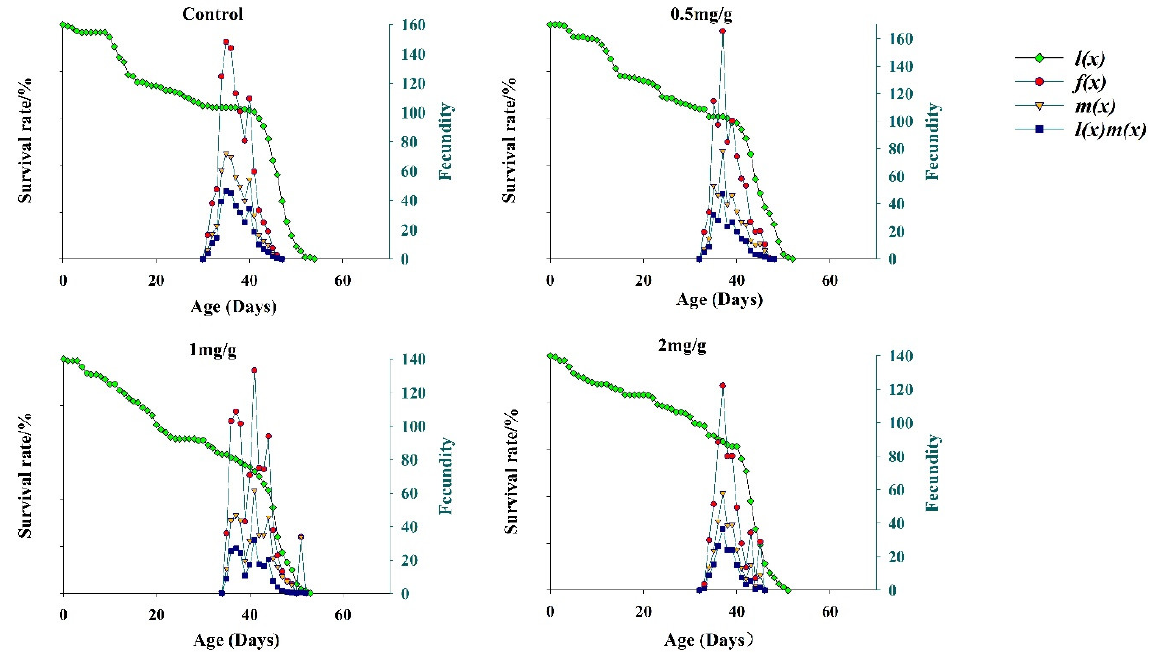
Figure 4. Population age-specific survival and fecundity of Spodoptera frugiperda at different GO con- centrations.